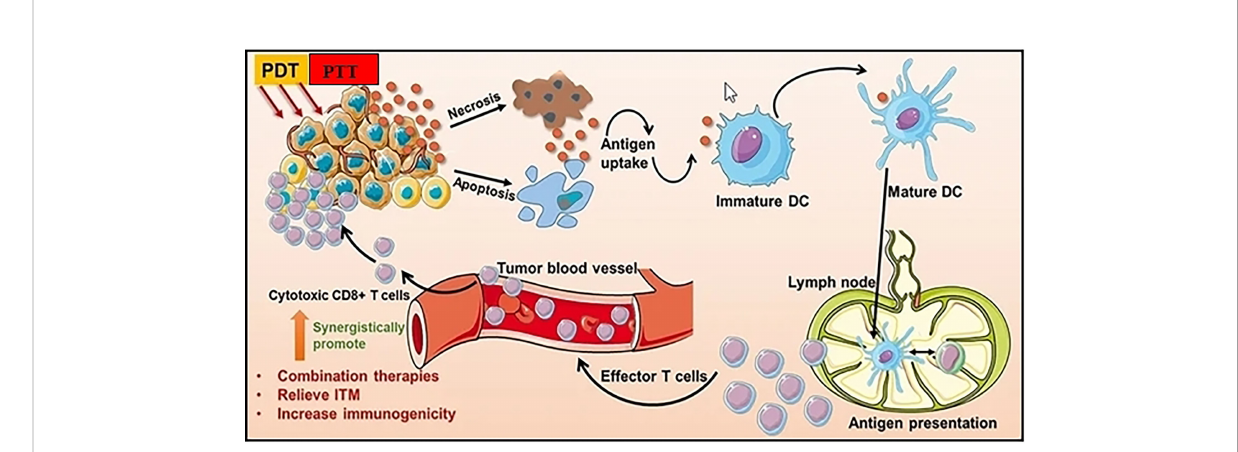
FIGURE 4 Photothermal and Photodynamic therapy can improve antitumor immune responses and increase tumor immunogenicity. Adapted with permission from Ref (59). Copyright 2021, Dove